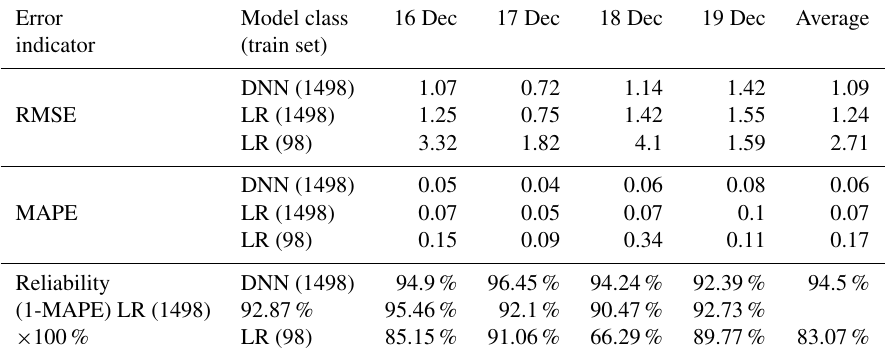
Reliability DNN (1498)